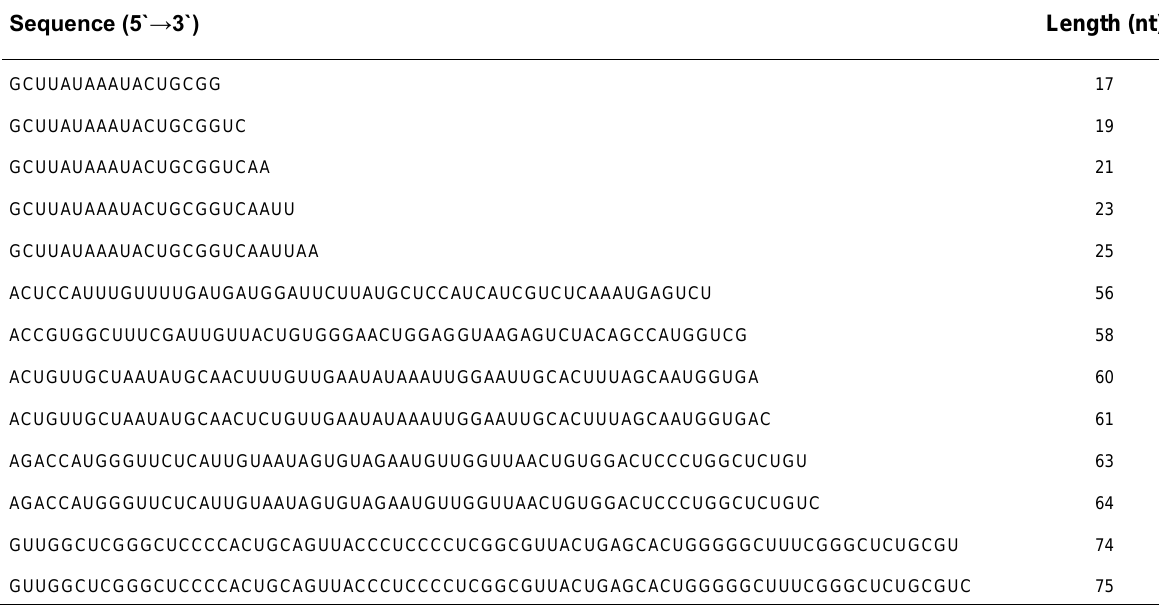
Sequences of the Synthetic ORNs used as RNA Size Markers Sequence